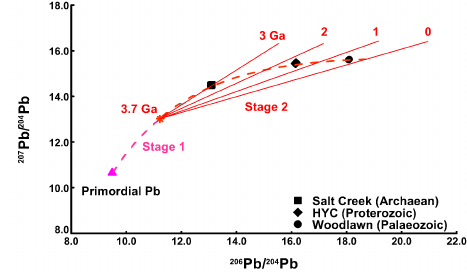
Figure 1. Stacey and Kramers (1975) two stage Pb evolution curve also showing Pb isotopic ratios for three high-Pb ore deposits of different geological ages (data from,